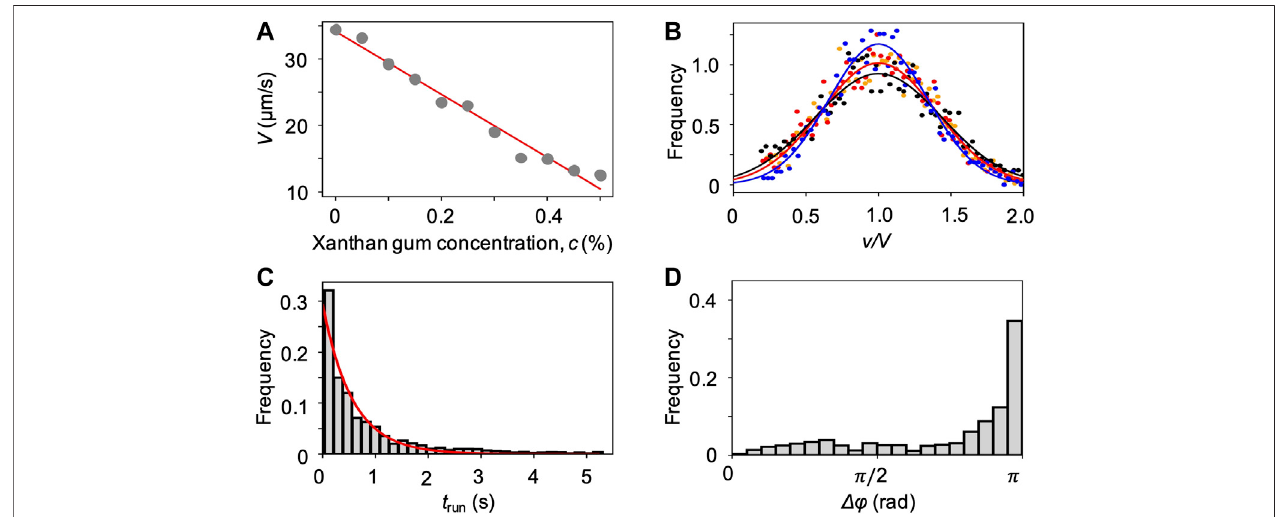
FIGURE 6 | (A) Mean swimming velocities V measured by tracking individual cells in a population of P. aeruginosa swimming in xanthan gum solutions at different concentrationsinno- fl owconditions.Thered curveisthelinear fi toftheexperimentaldata (Eq.2) . (B) Distributionofswimming velocities asafunctionofthenormalized velocity v/V , in buffer (yellow), and in xanthan gum solutions at 0.05 w/v% (red), 0.1 w/v% (black), and 0.2 w/v% (blue) in no- fl ow conditions. The continuous curves are Gaussian fi tswiththemeanvelocities V reportedin (A) . (C) Distributionofthetransit times t run measured bytracking individualcellsinapopulation of P.aeruginosa swimminginthe0.1w/v%xanthangumsolution.Theredcurveistheexponential fi tofthedistribution. (D) Distributionoftheangularchanges Δφ associatedwithreverse and pause events, measured by tracking individual cells in a population of P. aeruginosa swimming in the 0.1 w/v% xanthan gum solution.